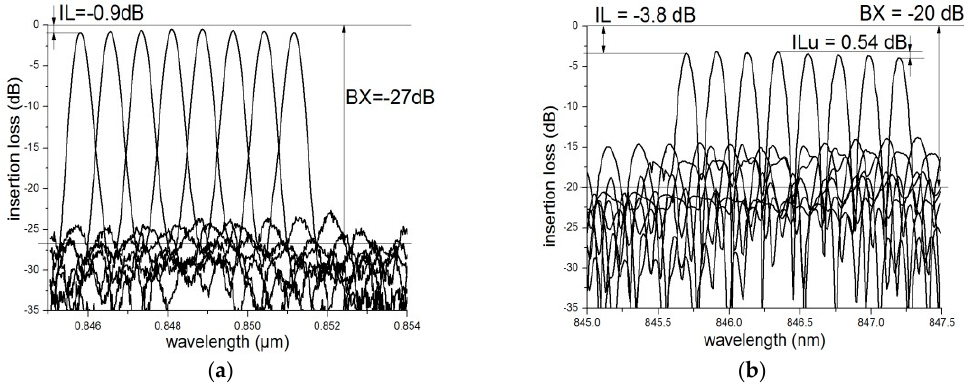
Figure 4. Simulated ( a ) and measured ( b ) spectral response of an 8-channel AWG (from